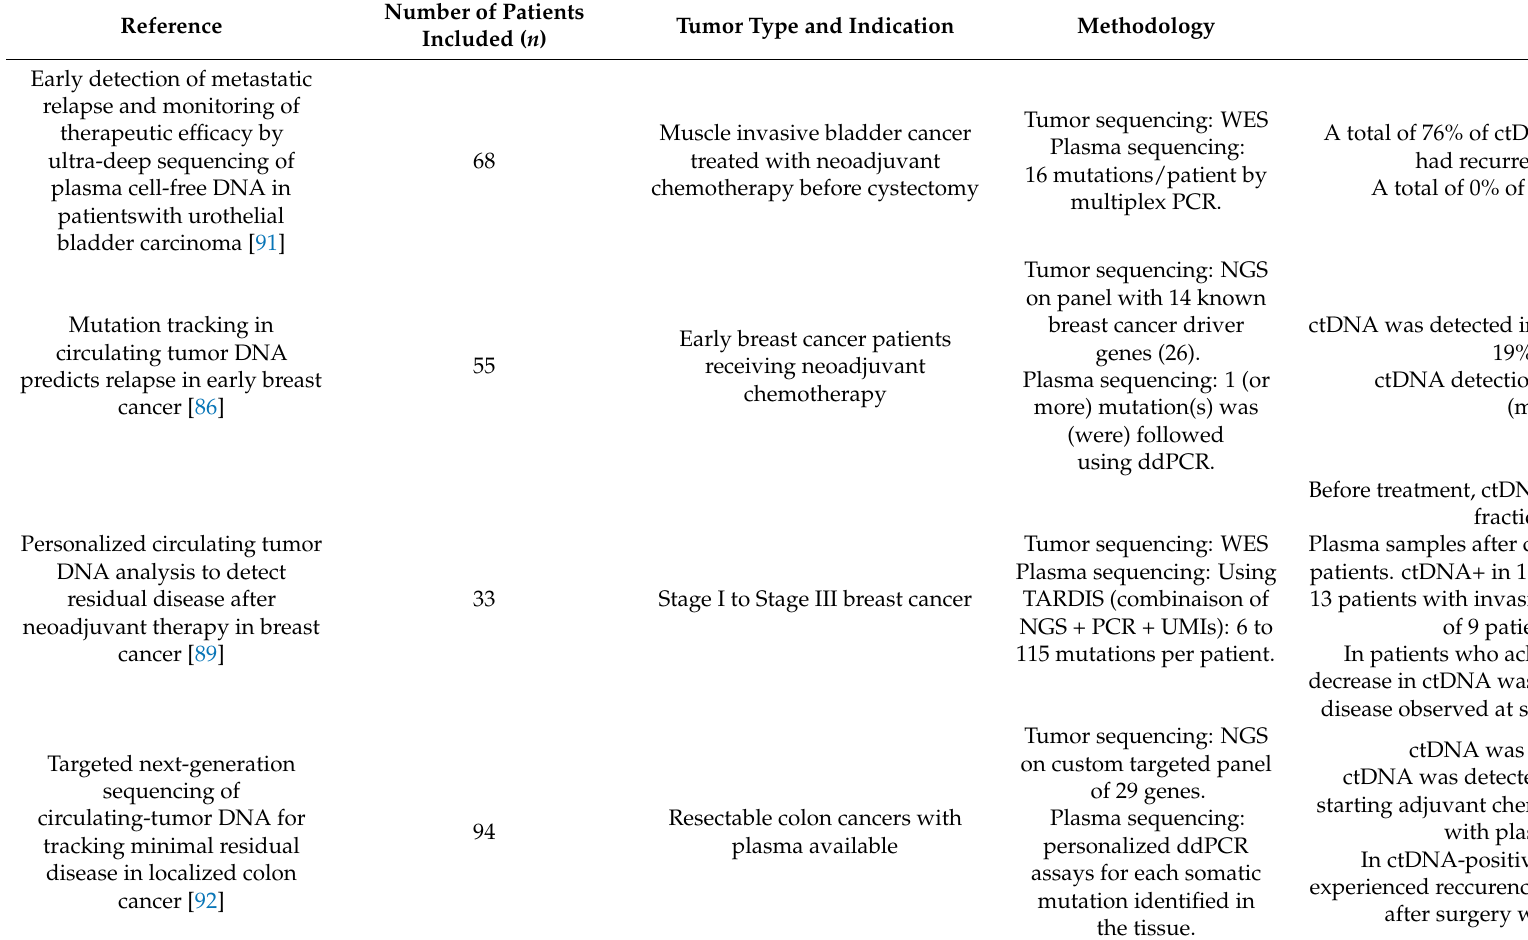
Table 1. Non-exhaustive list of published trials with personalized methods to identify MRD through ctDNA